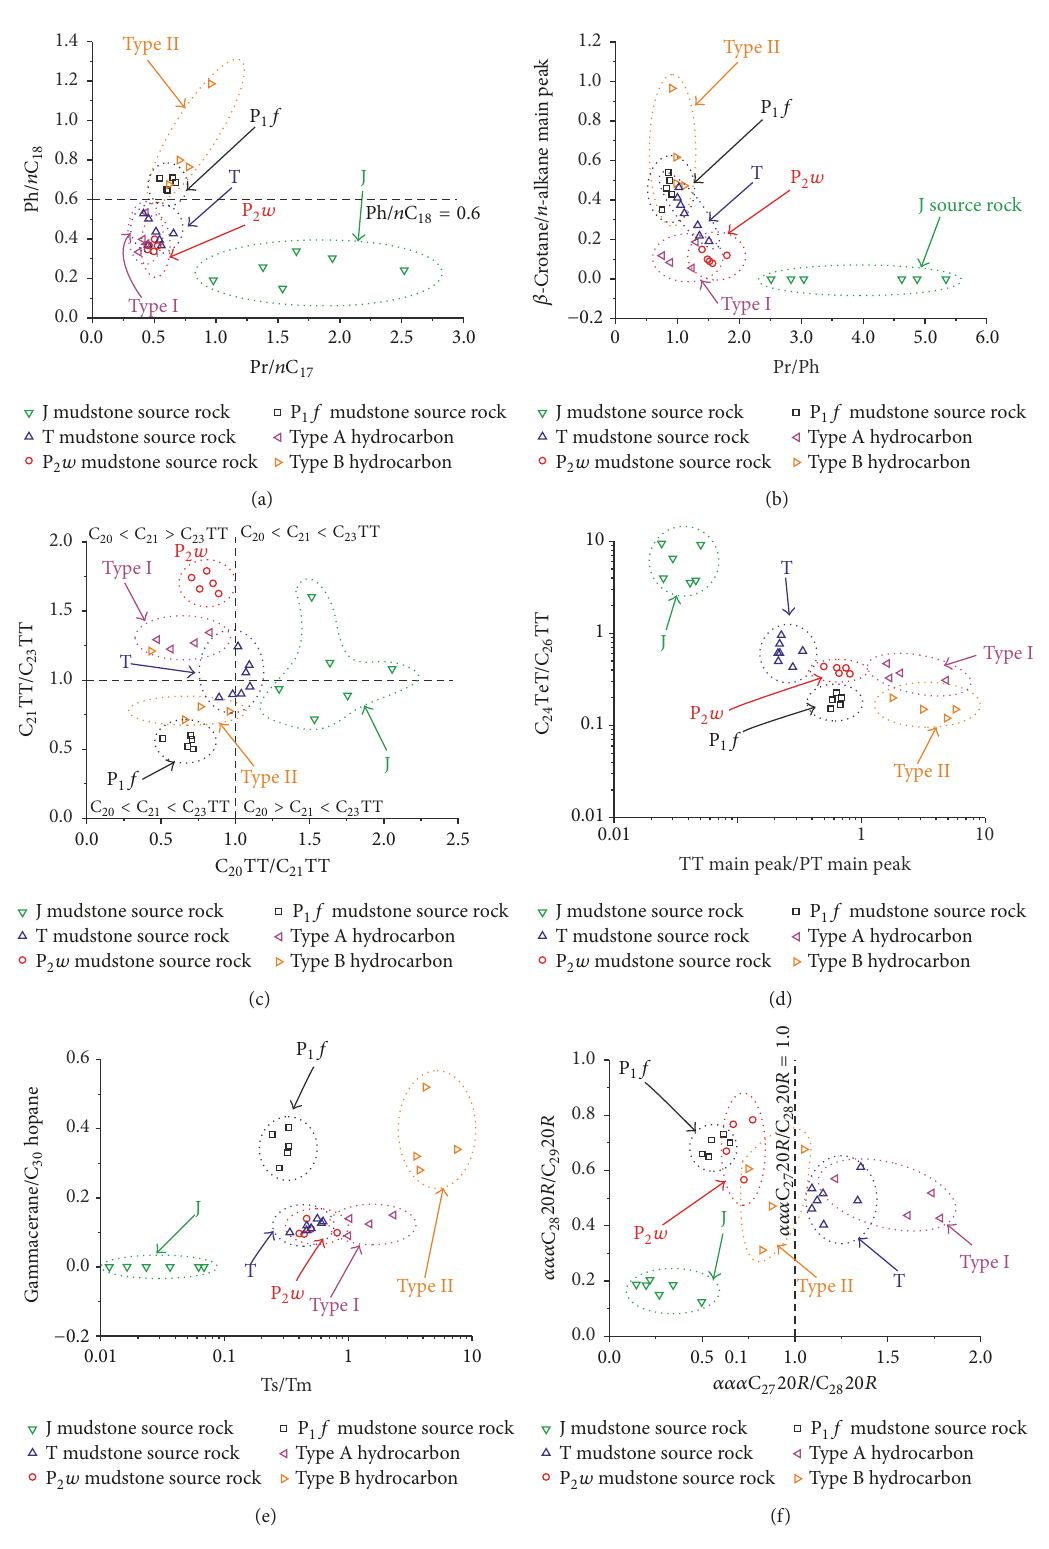
Figure 5: Correlation of key biomarkers that distinguish the Permian, Jurassic, and Triassic mudstone source rocks and Triassic oil-source correlation in the central Junggar Basin. (a) Pr/ n -C 17 versus Ph/ n -C 18 ; (b) Pr/Ph versus 𝛽 -carotane/ n -alkane main peak; (c) C 20 /C 21 TT versus C 21 /C 23 TT; (d) regular sterane 𝛼𝛼𝛼 C 27 20 R /C 28 20 R versus 𝛼𝛼𝛼 C 28 20 R /C 29 20 R ; (e) Ts/Tm versus gammacerane/C 30 hopane; (f) TT main peak/PT main peak versus C 24 TeT/C 26 TT. TT: tricyclic terpane. TeT: tetracyclic terpane. PT: pentacyclic